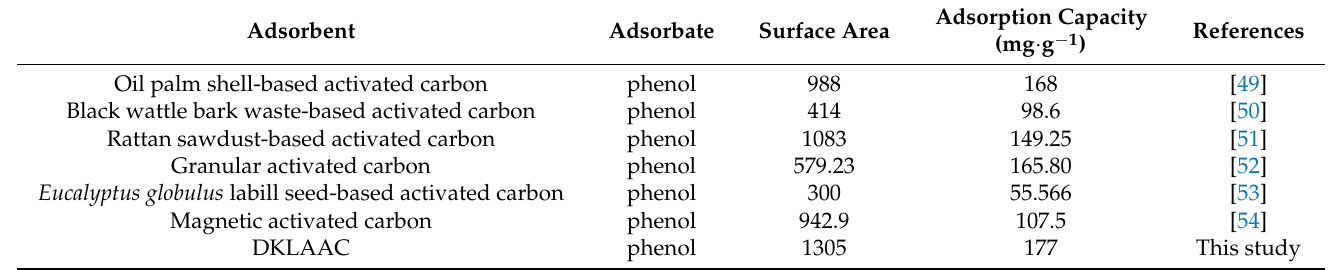
Table 2. Comparison of adsorption capacities of different adsorbents with DKLAAC for the removal of phenol, 2-NP, and 4-NP as reported in the